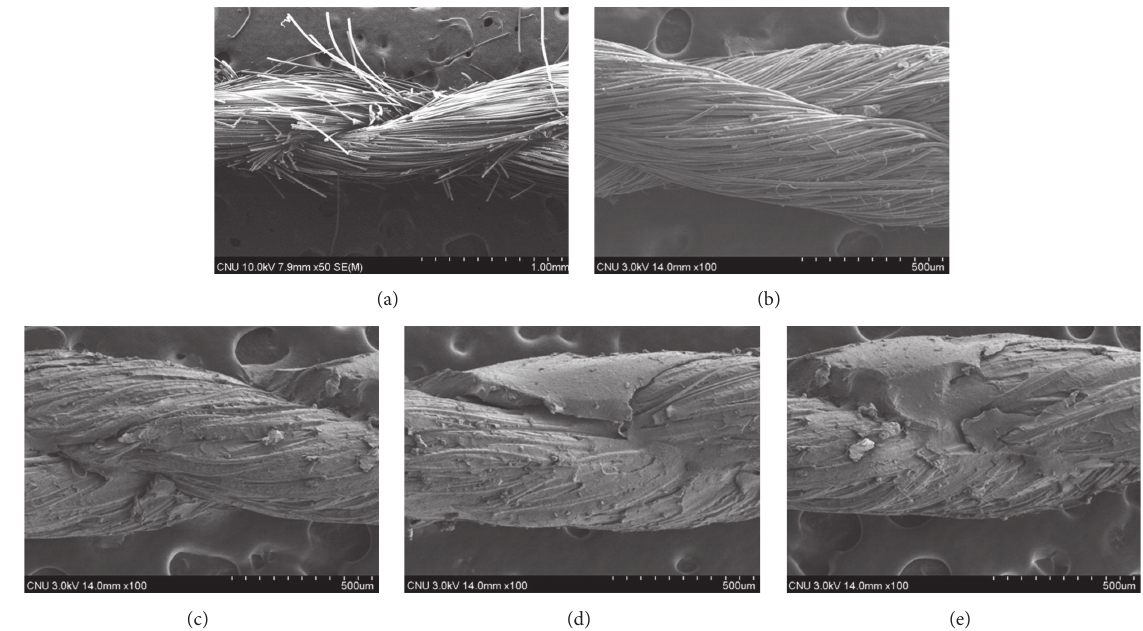
Figure10:SEMphotographsofadhesionfracturesurfaceofpolyketone/NRcomposites;(a)primeruntreatedandnonaged,(b)primertreated and nonaged, and (c) primer treated and thermal aged at 105 ∘ C, (d) 125 ∘ C, and (e) 180 ∘ C.